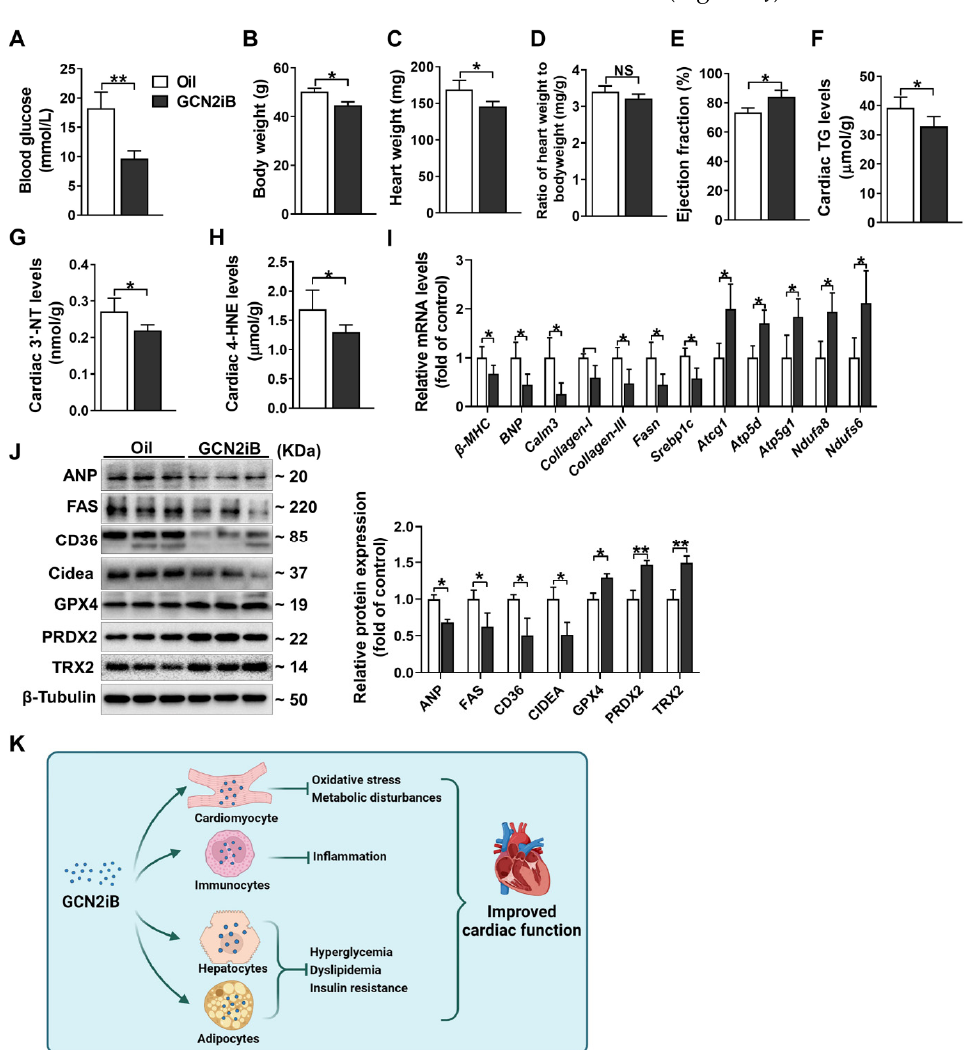
Figure 5. GCN2iB improves cardiac function and alleviates myocardial oxidative stress and lipid accumulation in db/db mice. Db/db mice were treated with GCN2iB (3 mg/kg) every other day via intraperitoneal injection for 6 weeks. Then, fasting blood glucose levels ( A ), body weight ( B ), heart weight ( C ), ratio of heart weight to body weight ( D ), left EF ( E ), cardiac TG levels ( F ), 3 ′ -NT levels ( G ) and 4-HNE levels ( H ) were measured. ( I ) The mRNA levels of genes related to hypertrophy, fibrosis, lipid metabolism and oxidative phosphorylation were measured. ( J ) Heart lysates were examined by Western blot. ( K ) Schematic diagram shows the potential target cell affected by GCN2iB in T2D mice. In Figure ( A – I ), N = 5; in Figure ( J ), N=3; values are expressed as the means ± SD; * indicates p < 0.05; ** indicates p <